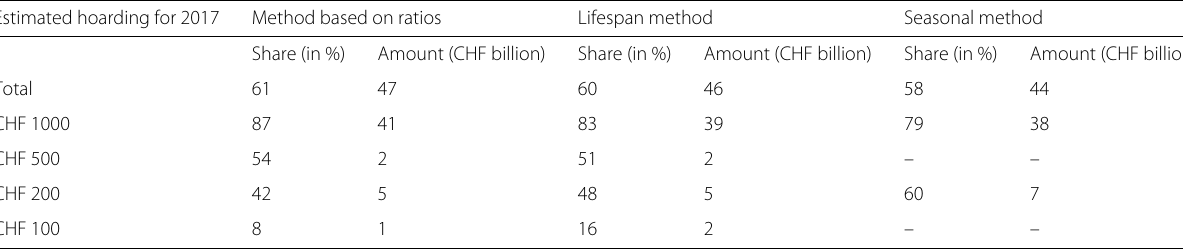
Table 2 Hoarding estimates for Swiss banknotes for 2017 Estimated hoarding for